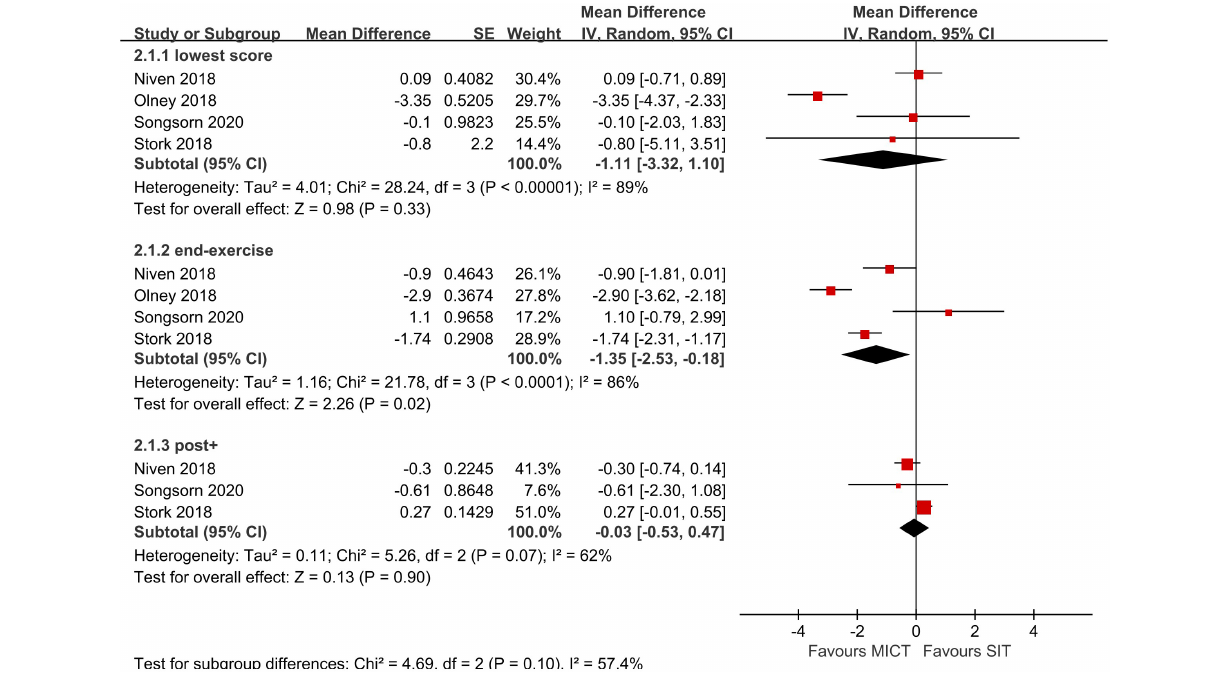
FIGURE 3 | Random effects meta-analyses for the influence of sprint interval training (SIT) vs. moderate-intensity continuous training (MICT) on affect.